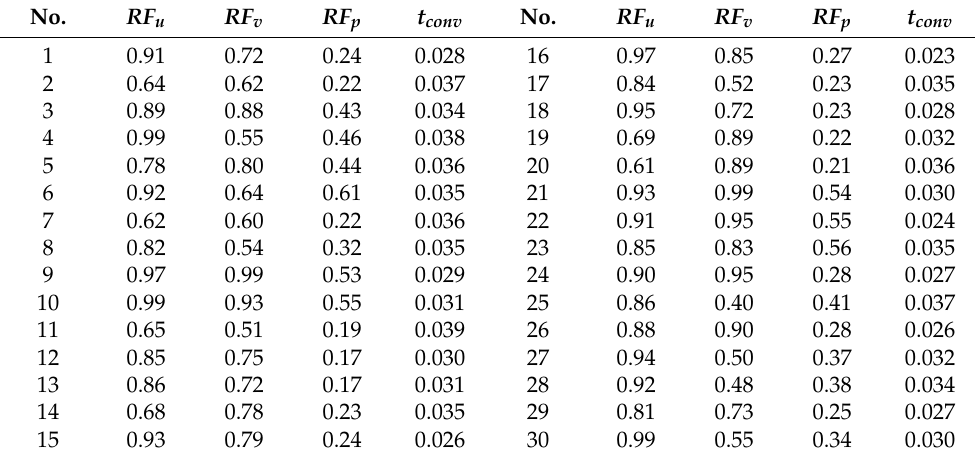
Table 9. Executions performed by SA for an 11 × 11 mesh and a residual value of ε = 1 × 10 − 5 , for the driven-cavity problem.